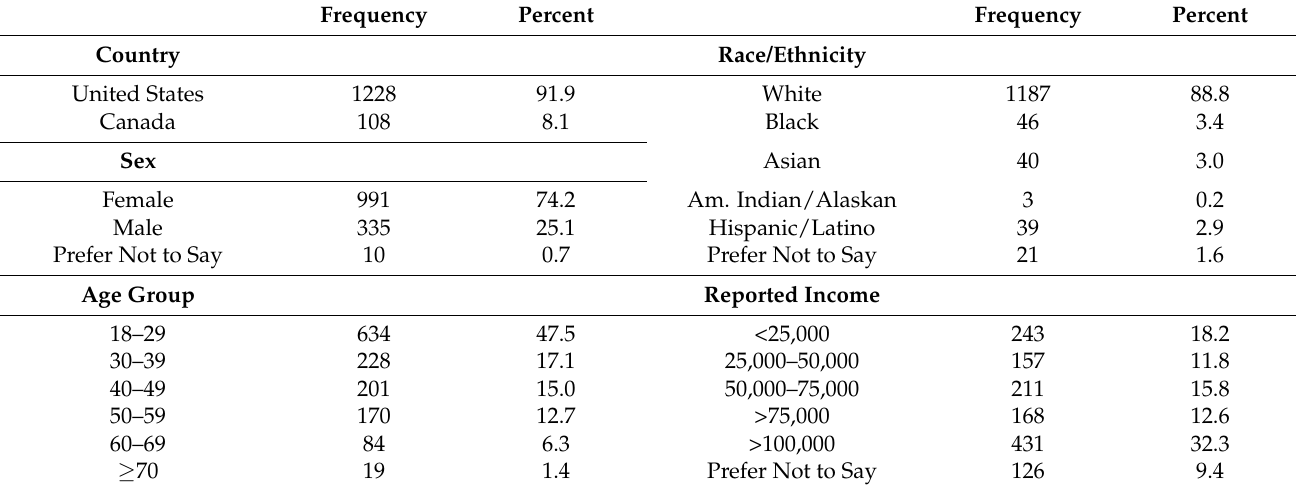
Table 1. Participant Characteristics ( n ,